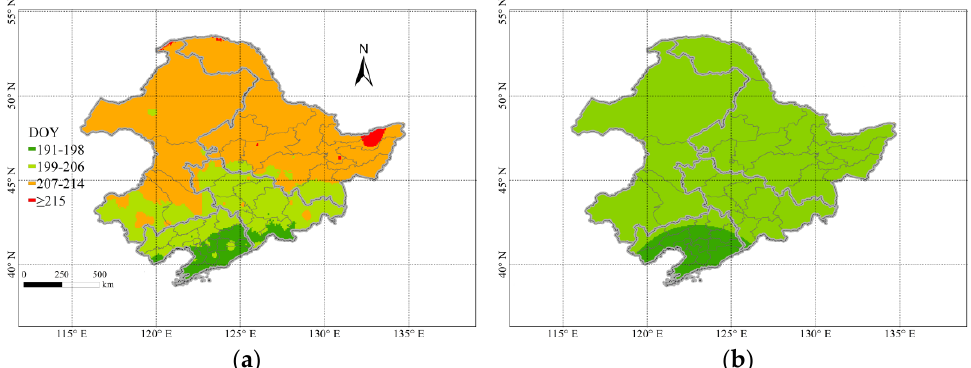
Figure 9. Maize flowering stage (FR) in Northeast China (( a ) fusion data; ( b ) original data).